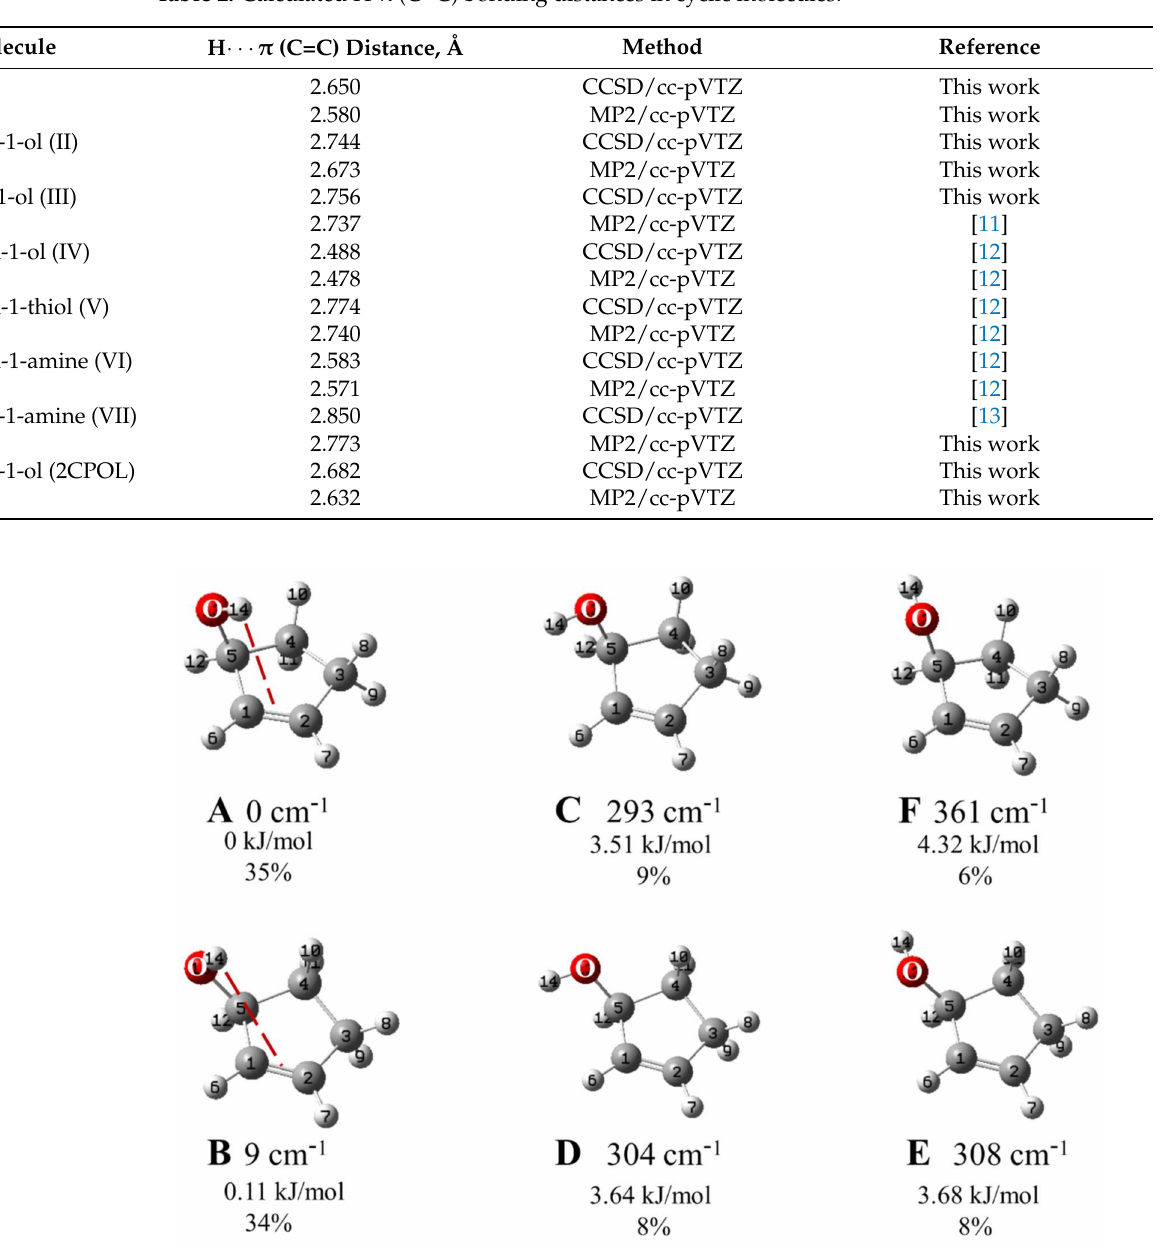
Table 2. Calculated H- π (C=C) bonding distances in cyclic molecules.